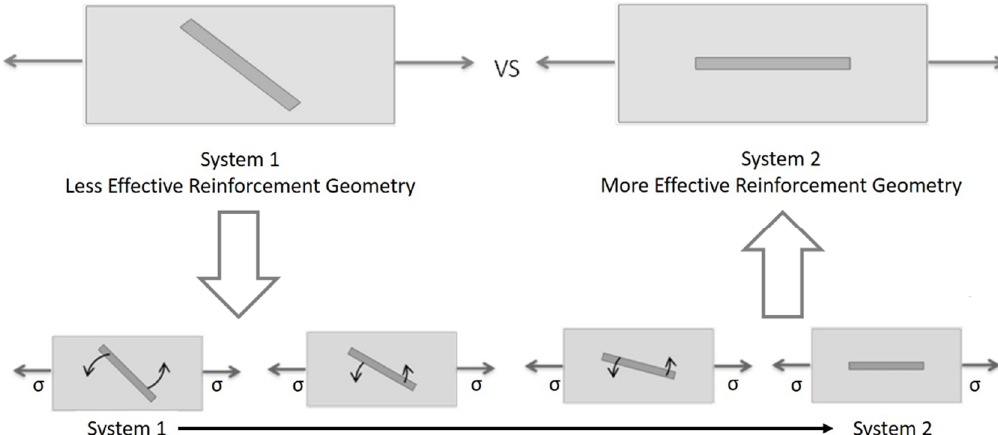
Figure 5. A geometric simplification of the region of the reinforcement between peak and trough and its evolution from less effective to more effective load carrying geometry representing the unbending process of a corrugation.